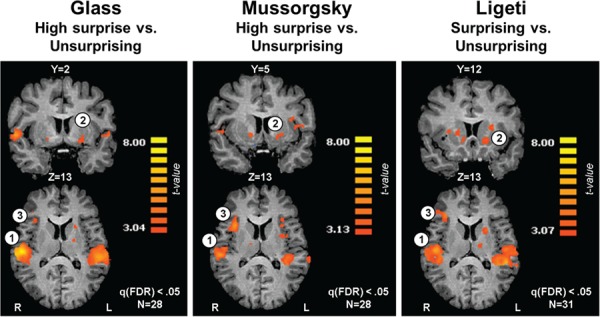
Modulation of brain activation as a function of surprise level. Across three distinct musical pieces [Glass, left (L); Mussorgsky, center; Ligeti, R], surprising events consistently elicited stronger activations relative to US events in the (1) auditory cortex, (2) VS and (3) anterior insula (P < 0.05, FDR-corrected). The high surprise vs US contrast is depicted for Glass and Mussorgsky. Images are presented in Talairach space and radiological convention.